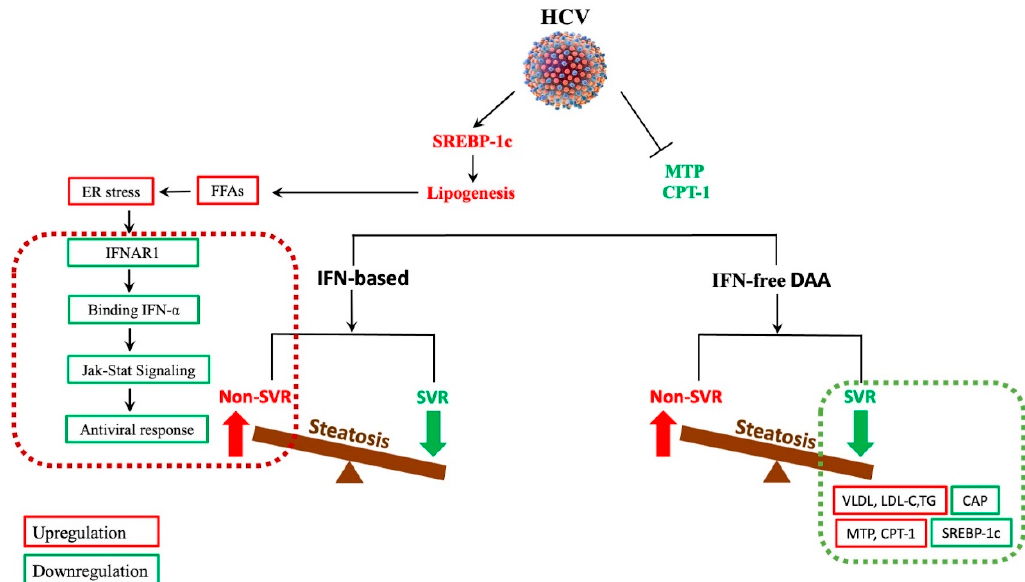
Figure 4. The effect of antiviral therapy on hepatitis C virus-associated steatosis. Red and green illustrate upregulation and downregulation, respectively. HCV: hepatitis C virus; SREBP-1c: sterol regulatory element-binding protein 1c; MTP: microsomal triglyceride transfer protein; CPT-1: carnitine palmitoyltransferase-1; FFAs: free fatty acids; ER: endoplasmic reticulum; IFNAR1: interferon alpha and beta receptor subunit 1; IFN- α : interferon-alpha; JAK/STAT: Janus kinase and signal transducer and activator of transcription signaling; IFN-based: interferon-based; SVR: sustained virological response; IFN-free DAA: interferon-free direct-acting antivirals; VLDL: very-low-density lipoprotein; LDL-C: low-density lipoprotein cholesterol; TG: triglycerides; CAP: controlled attenuation parameter.